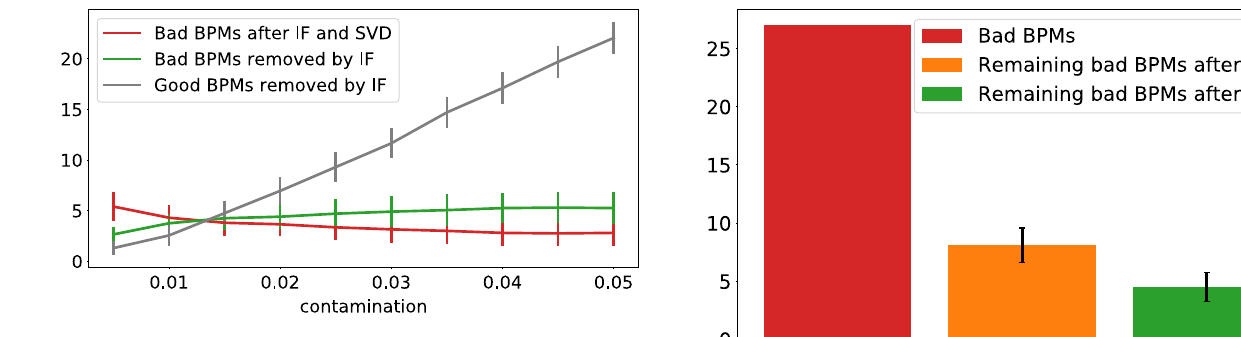
FIG. 8. Adjustment of contamination factor of the IF algorithm after changing the SVD cut to its lowest optimal value 0.3.